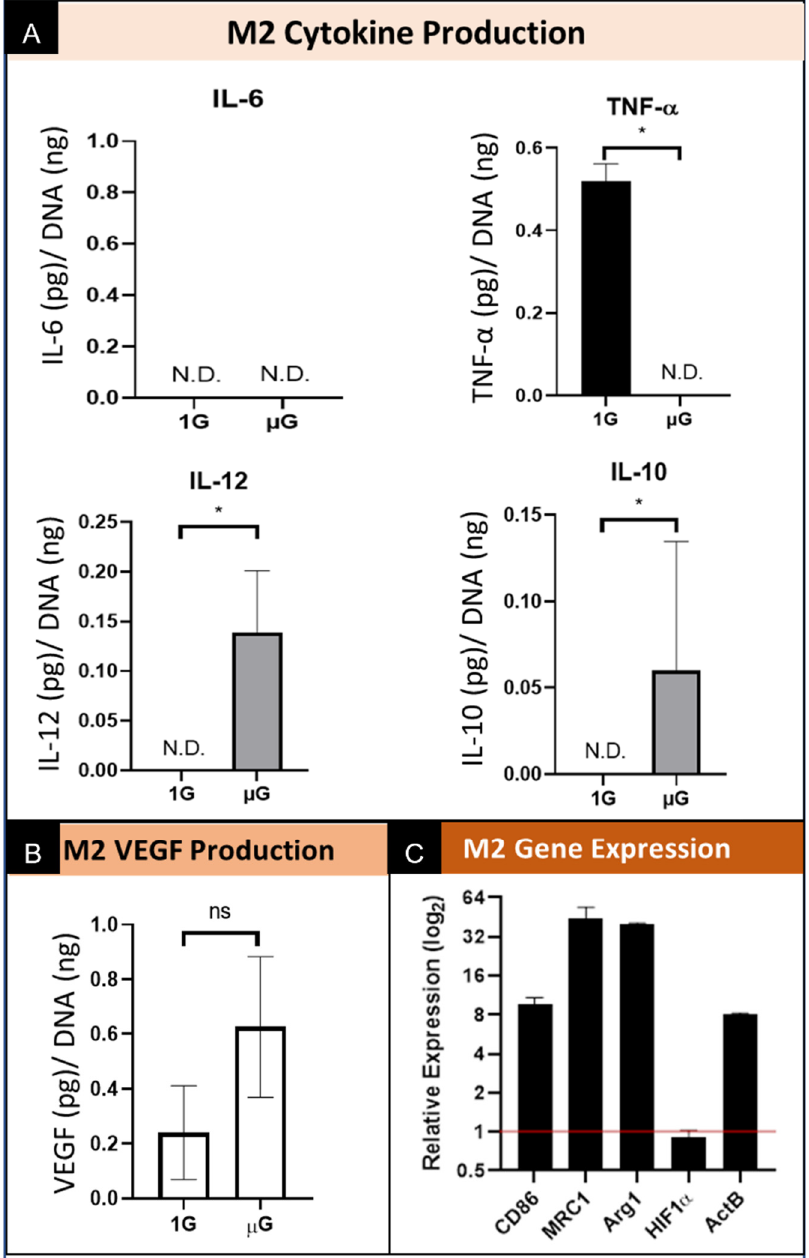
Figure 5. Summary of the effect of simulated microgravity on M2 macrophage protein and gene expression. ( A ) Quantification of M2 macrophage secretion of inflammatory cytokines while cultured in both normal gravity (1G) and simulated microgravity (µG) for IL-6, TNF- α , IL-10, and IL-12. Data normalized to DNA concentration and are presented as Mean +/- SD, n = 3. N.D. indicates the concentration did not reach the threshold for the assay and thus is Not Detected. Significance determined by unpaired Student’s t-test; * denotes p < 0.05. ( B ) Quantification of VEGF secretion by M2 macrophages cultured in normal gravity (1G) and simulated microgravity (µG). Data normalized to DNA concentration and are presented as Mean +/- SD, n = 3; Significance determined by unpaired Student’s t-test; ns denotes non-significant. ( C ) Gene expression of M2 phenotype macrophages for M1 specific (CD86) and M2 specific (MRC1 and Arg1) genes, HIF1 α , and ActB. Data displayed as relative expression of simulated µG samples compared to 1G controls (red line).